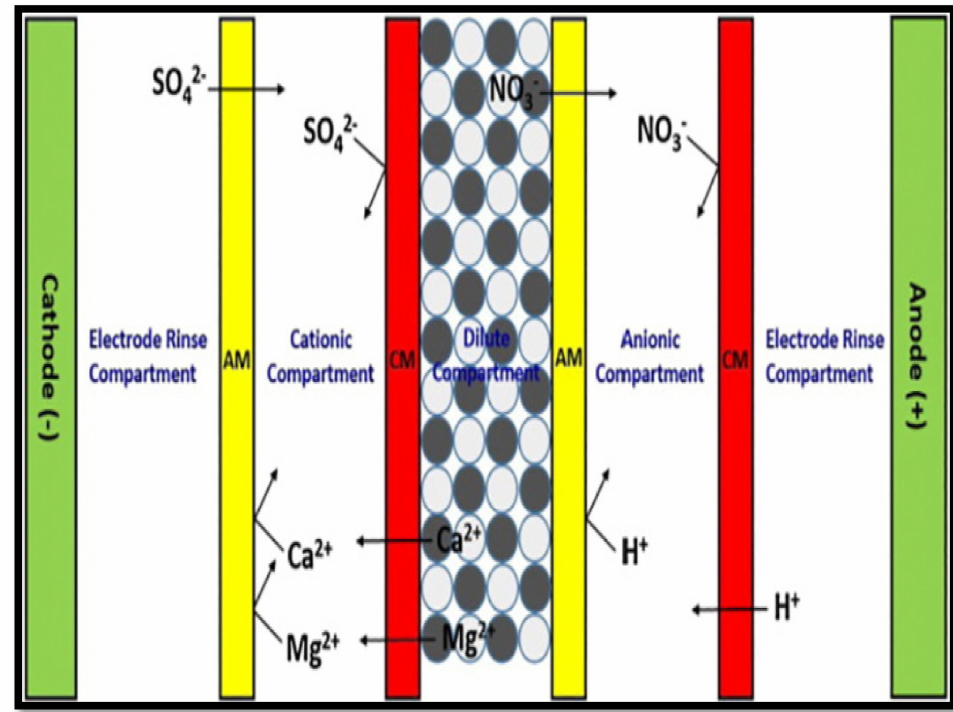
Figure 12. Schematic diagram of electrodialysis [100], with permission from Elsevier.